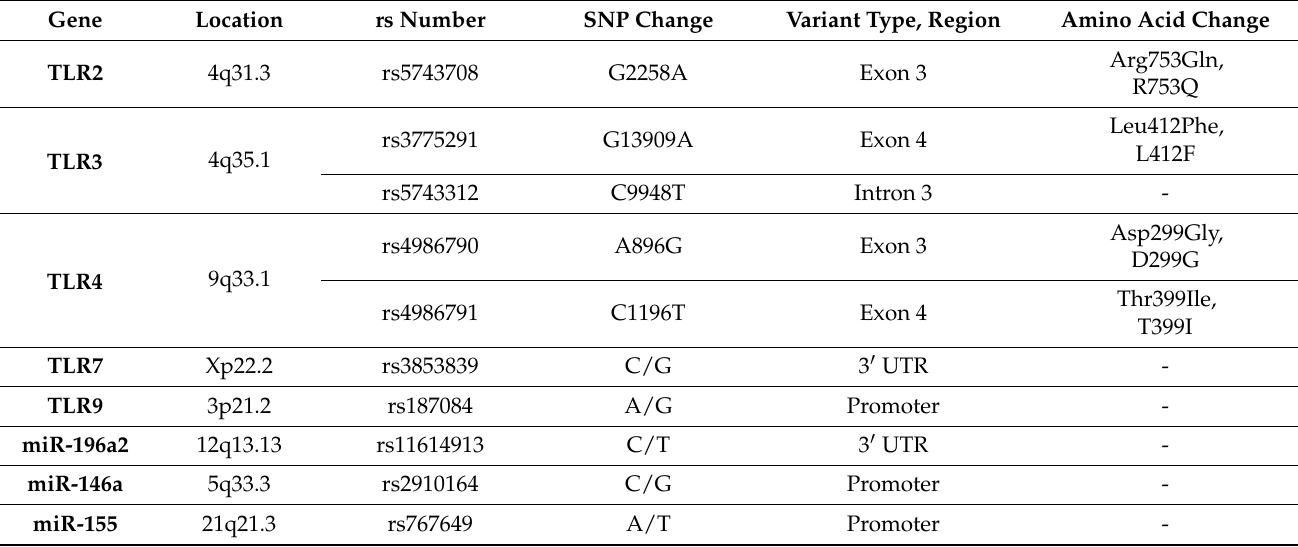
Table 1. Characteristics of genotyped TLR and miRNA